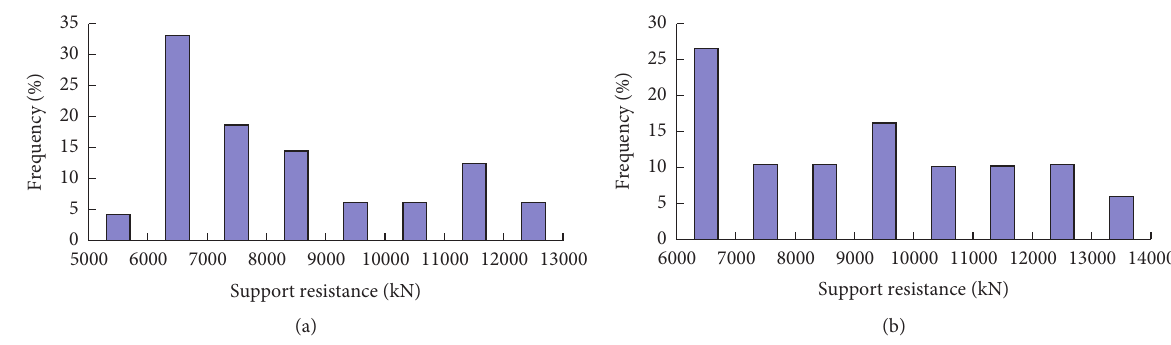
Figure 4: Distribution histogram of powered support working resistance. (a) 4.0m mining height. (b) 7.5m mining Table 2: The statistics of coal recovery ratio in different stages. 4 m mining height